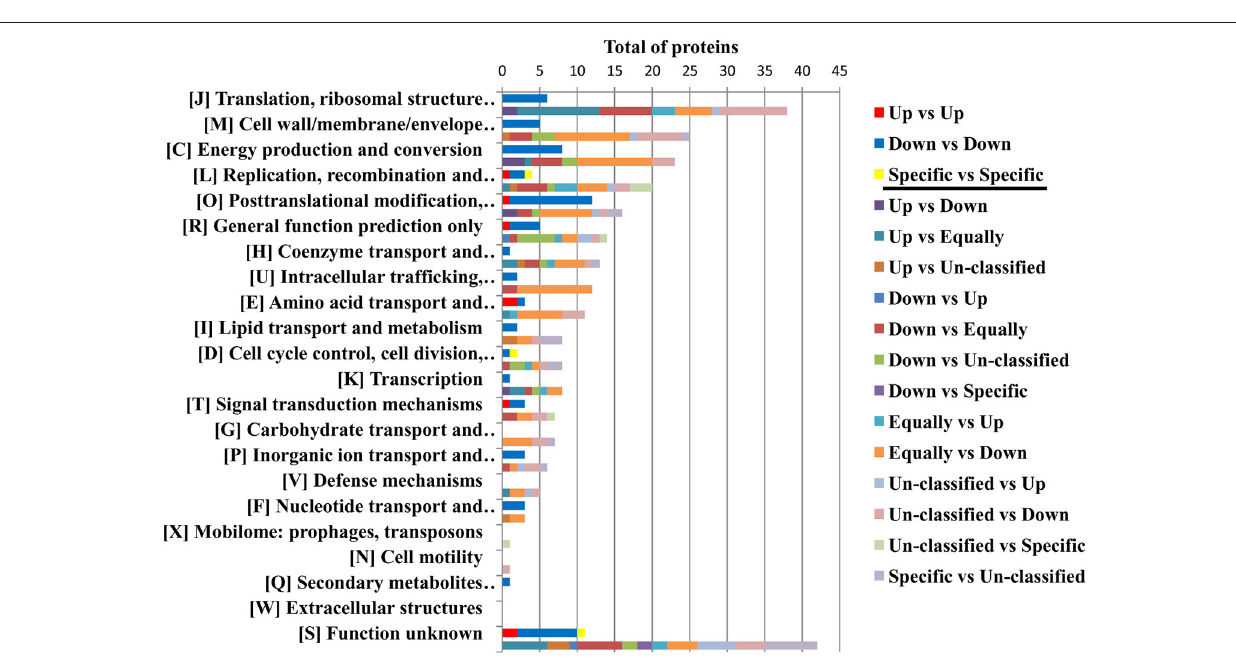
FIGURE 7 | Similar and distinct protein patterns obtained between the SENLAT agents (the virulent R. slovaca Rsl/the milder R. raoultii Rra) and the MSF agents (the virulent R. conorii Rco/the milder R. massiliae Rma), as classified by COG functional categories. Up, Down, Equally, Specific and Un-classified mean up-regulated, down-regulated, equally regulated, specific and un-classified proteins,